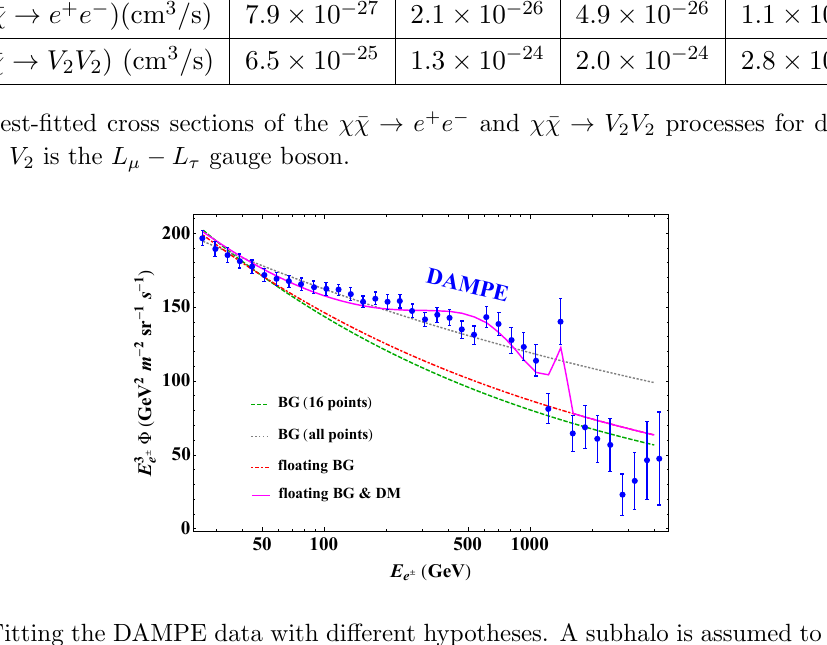
Figure 3 . Fitting the DAMPE data with di(cid:11)erent hypotheses. A subhalo is assumed to be 0.3 kpc away from us. The green line (dashed) is the best-(cid:12)t background obtained by (cid:12)tting the (cid:12)rst eight and last eight DAMPE data points. The gray line (dotted) is the best-(cid:12)t background obtained by (cid:12)tting all the DAMPE data points. The magenta line (solid) is the best-(cid:12)t electron (cid:13)ux when one (cid:12)ts the DAMPE data with the sum of a (cid:13)oating background and DM contributions. The red line (dot-dashed) indicates the background component of the magenta